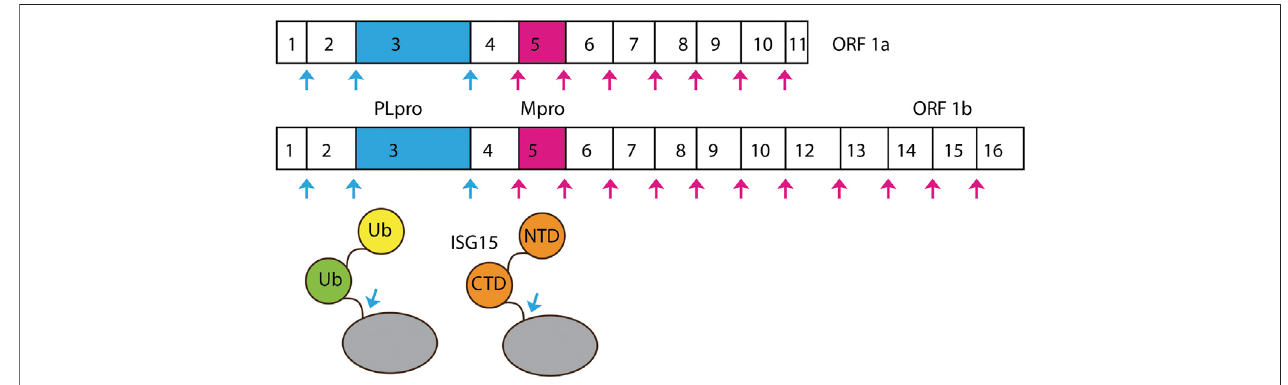
FIGURE 1 | Cleavage sites of PLpro and Mpro. SARS-CoV-2 ORF1a is processed by PLpro and Mpro into